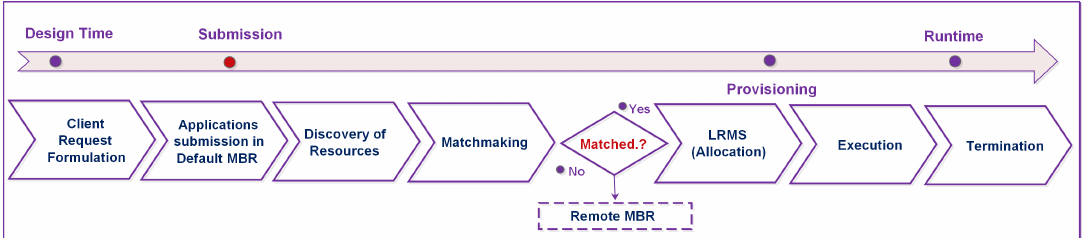
Figure 7. Applications in different phases.